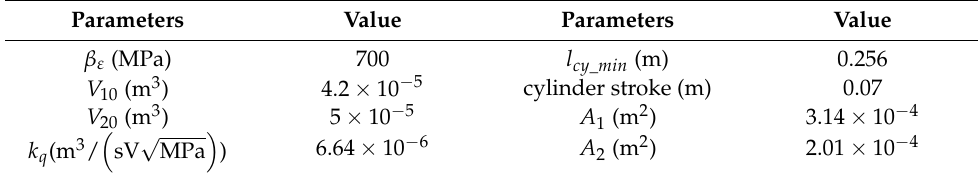
Table 2. Parameters of the hydraulic